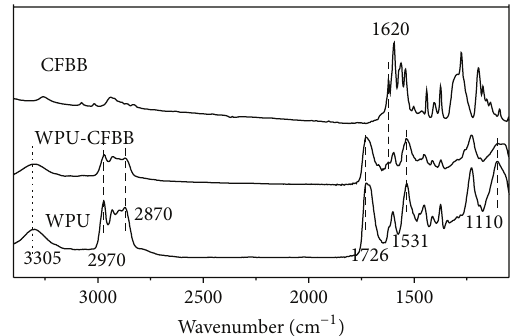
Figure 1: FTIR spectra of WPU, WPU-CFBB, and CFBB.